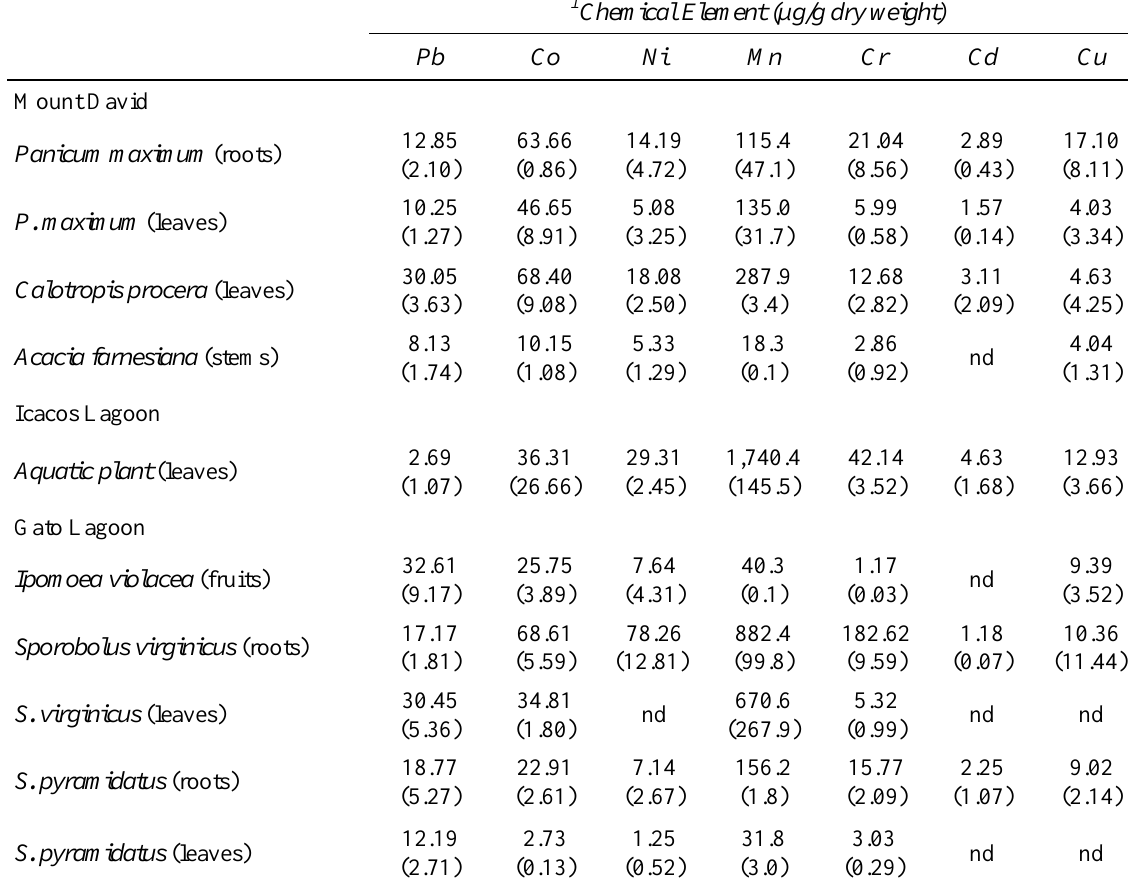
Table 1: Elemental analysis of terrestrial plant material collected at the AFWTF, Vieques (Puerto